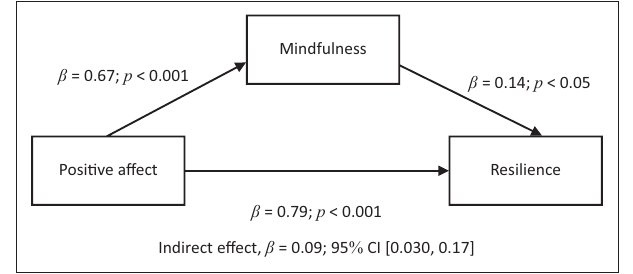
FIG URE 1: The mediating effect of mindfulness on the relationship between positive affect and resilience.